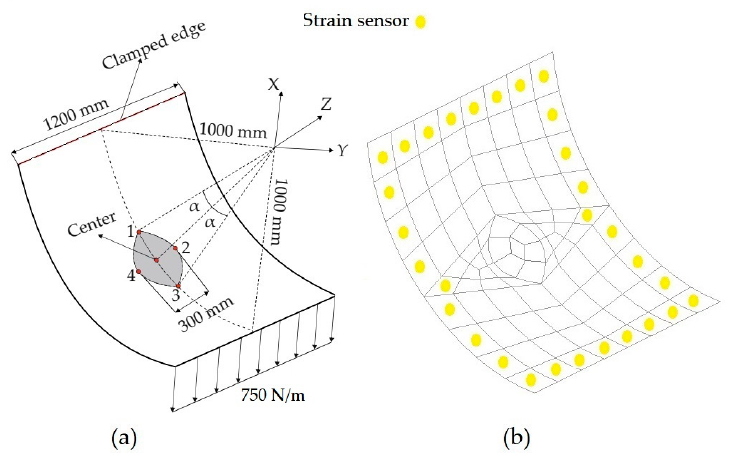
Figure 15. ( a ) Dimensions of the curved plate with a damaged region at the center; ( b ) sensor placement model for iCS8/iQS4 discretization.